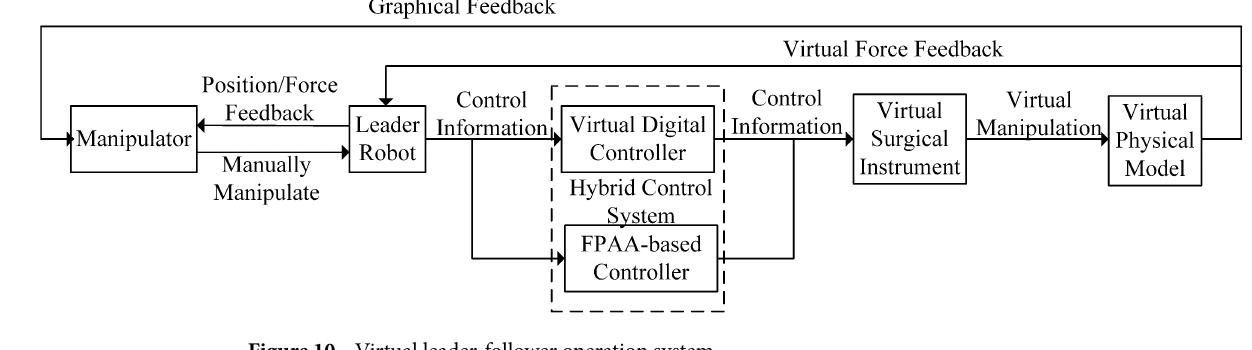
Figure 10. Virtual leader-follower operation